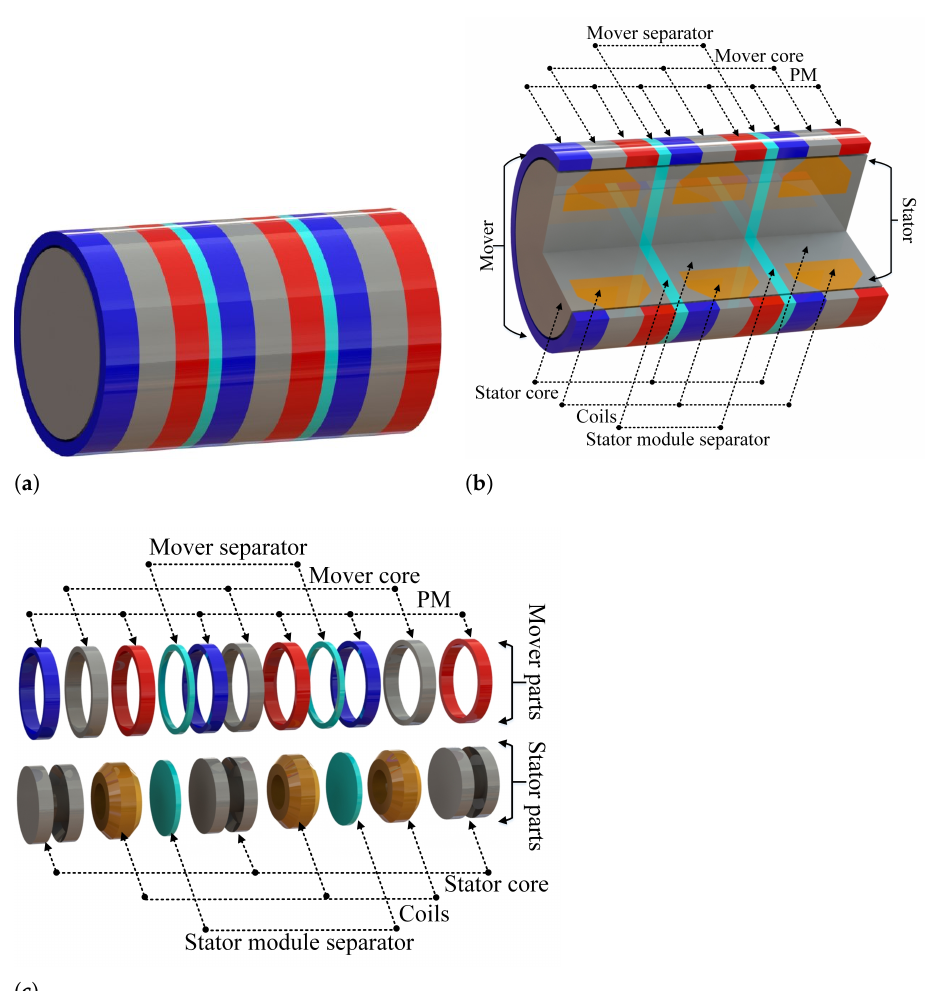
Figure 2. Three-dimensional model of TMM-LOA: ( a ) full assembly; ( b ) cross-sectional view; and ( c ) exploded